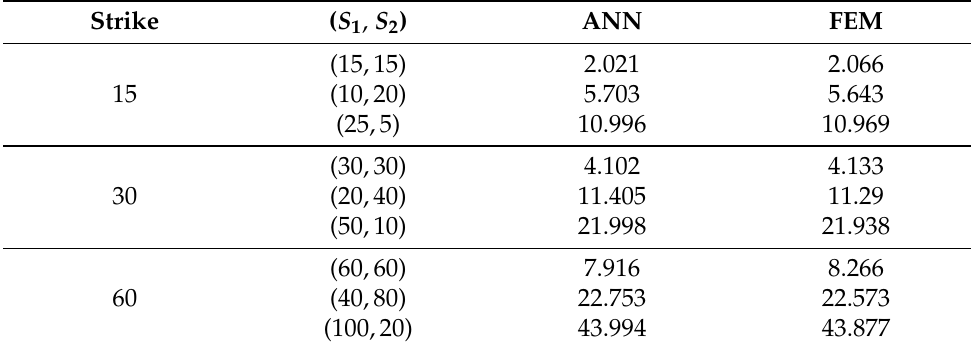
Table 7. Comparison of American max-call option